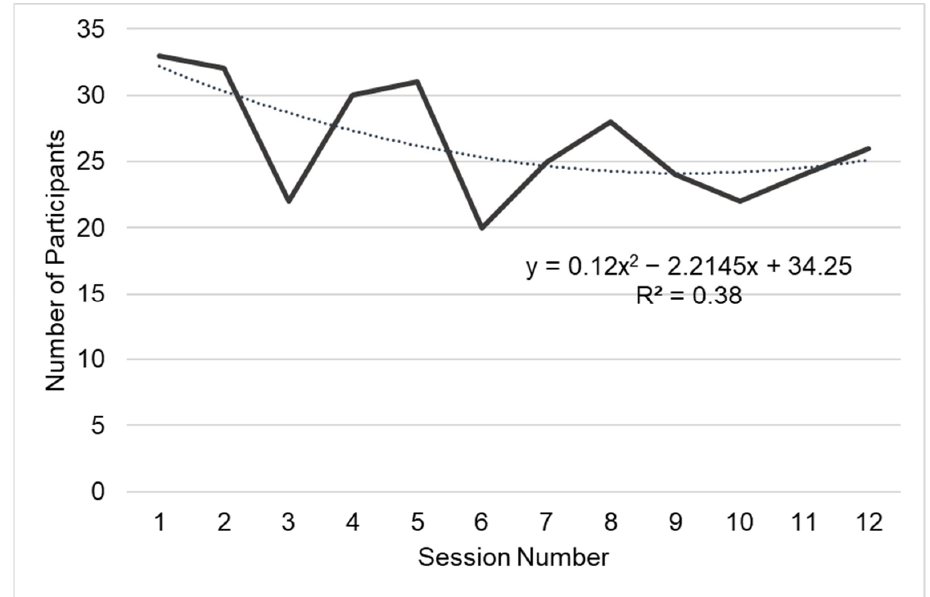
Figure 5. Evolution of the number of participants per session.